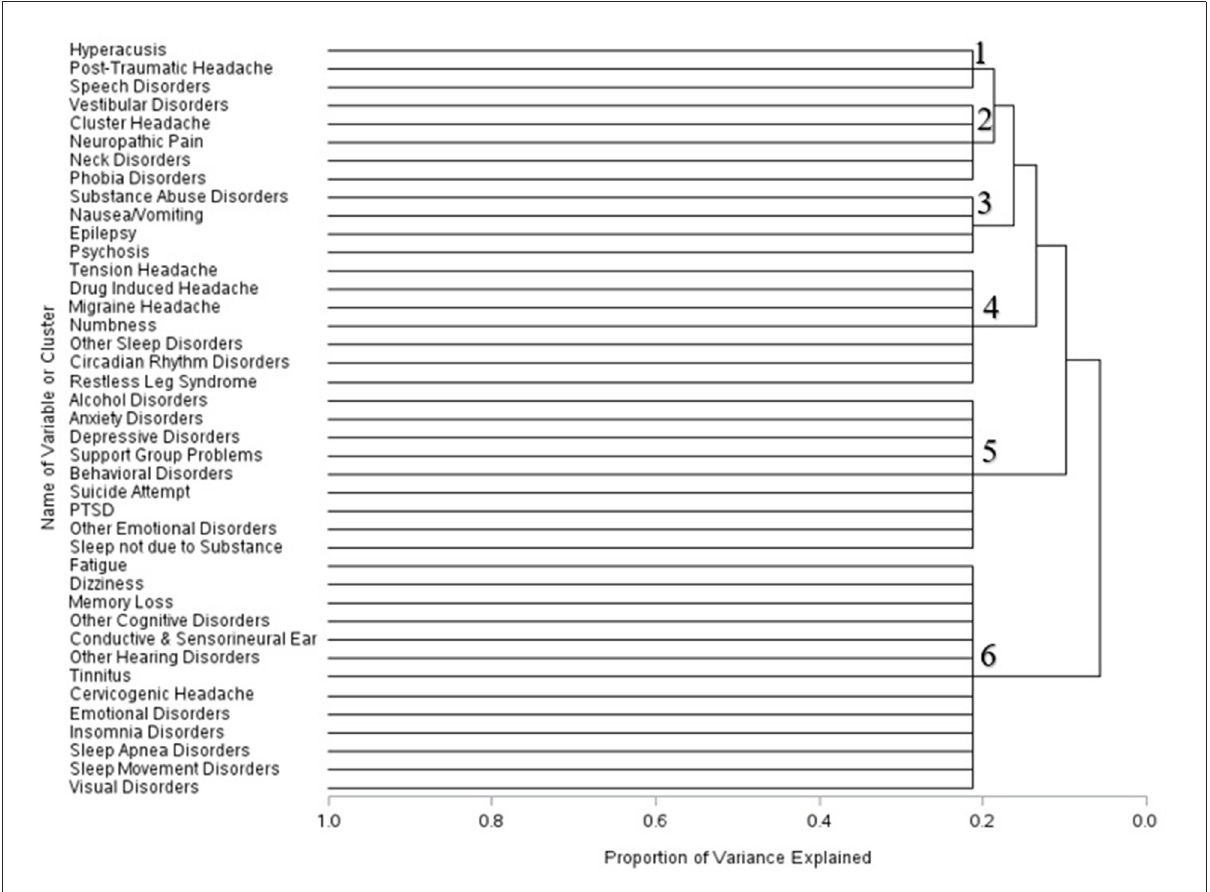
FIGURE2 Dendrogram of condition clusters among mTBI patients three